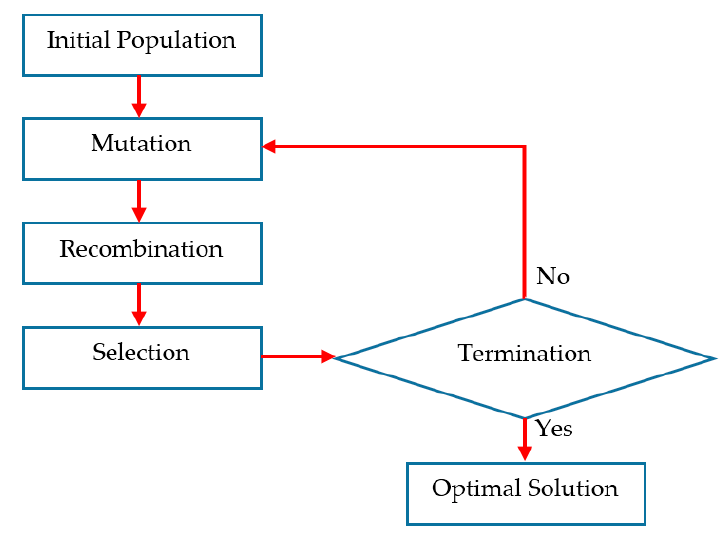
Figure 3. General differential evolution algorithm procedure.